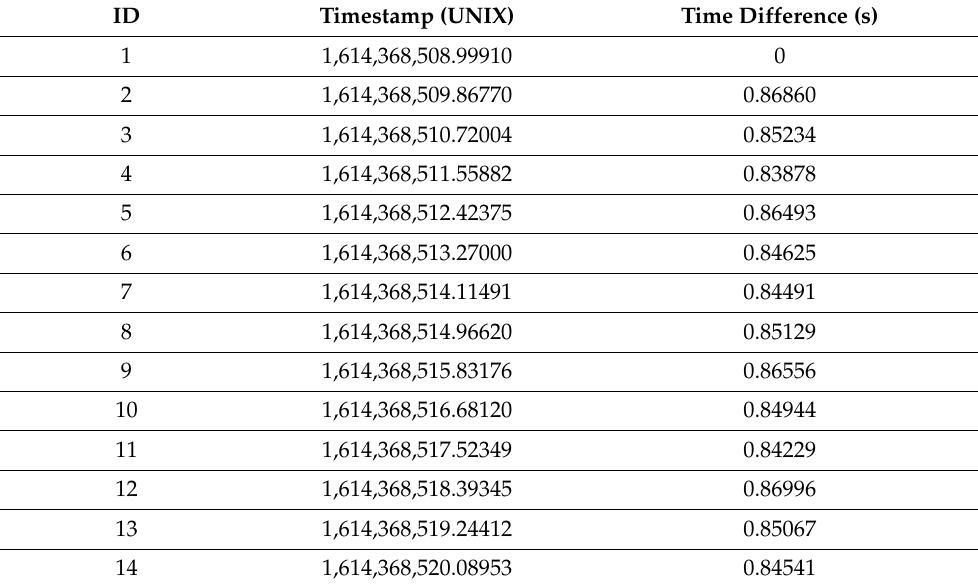
Table 5. Sample of calculating the update rate of a LiDAR scanner.